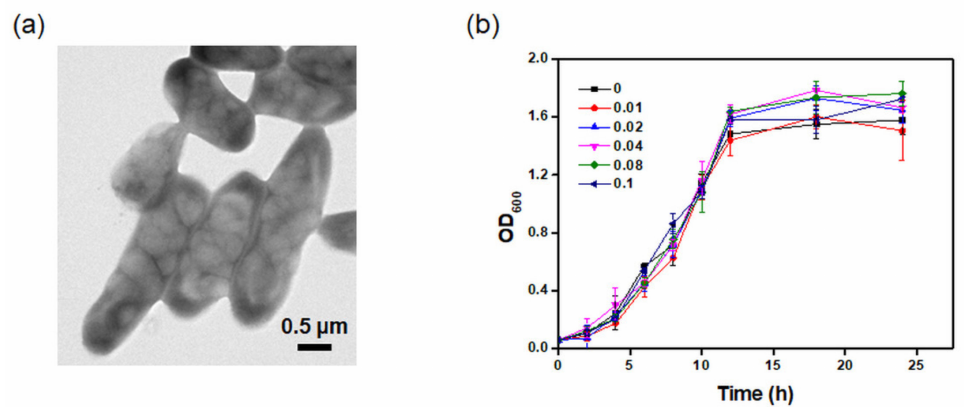
Figure 1. ( a ) TEM image of C. necator with PHB granules and ( b ) growth of C. necator after 24 h of incubation with different concentrations of CNCs (0–0.1 g/L).